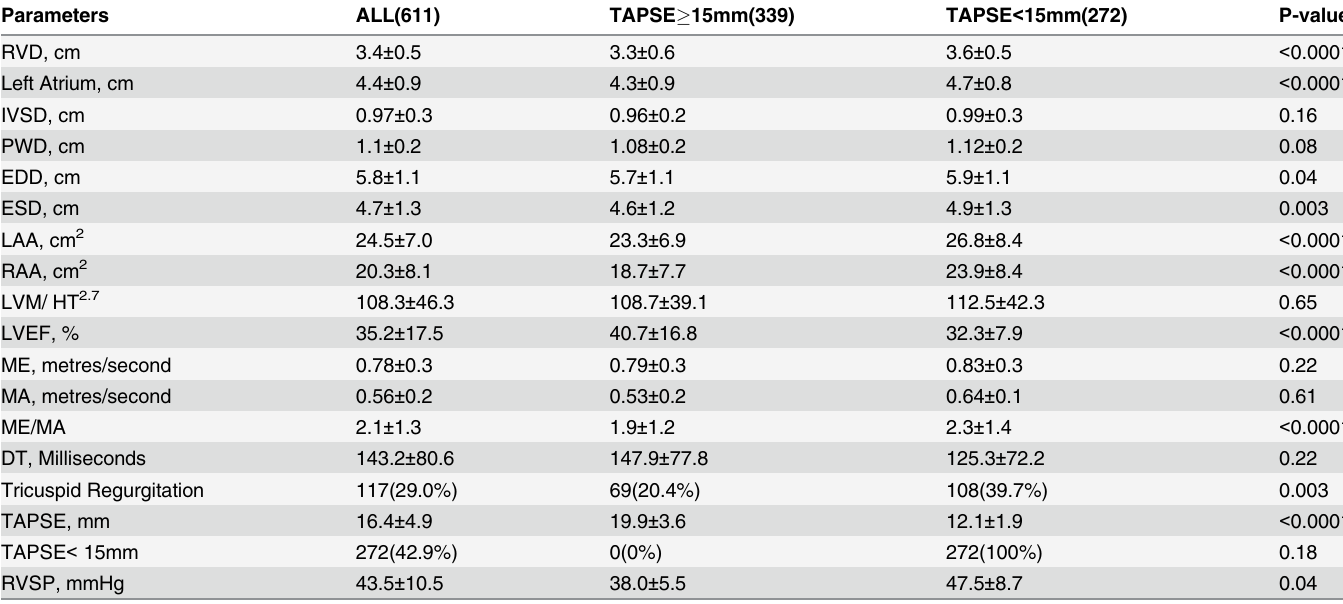
Table 2. Echocardiographic Profile of Subjects.